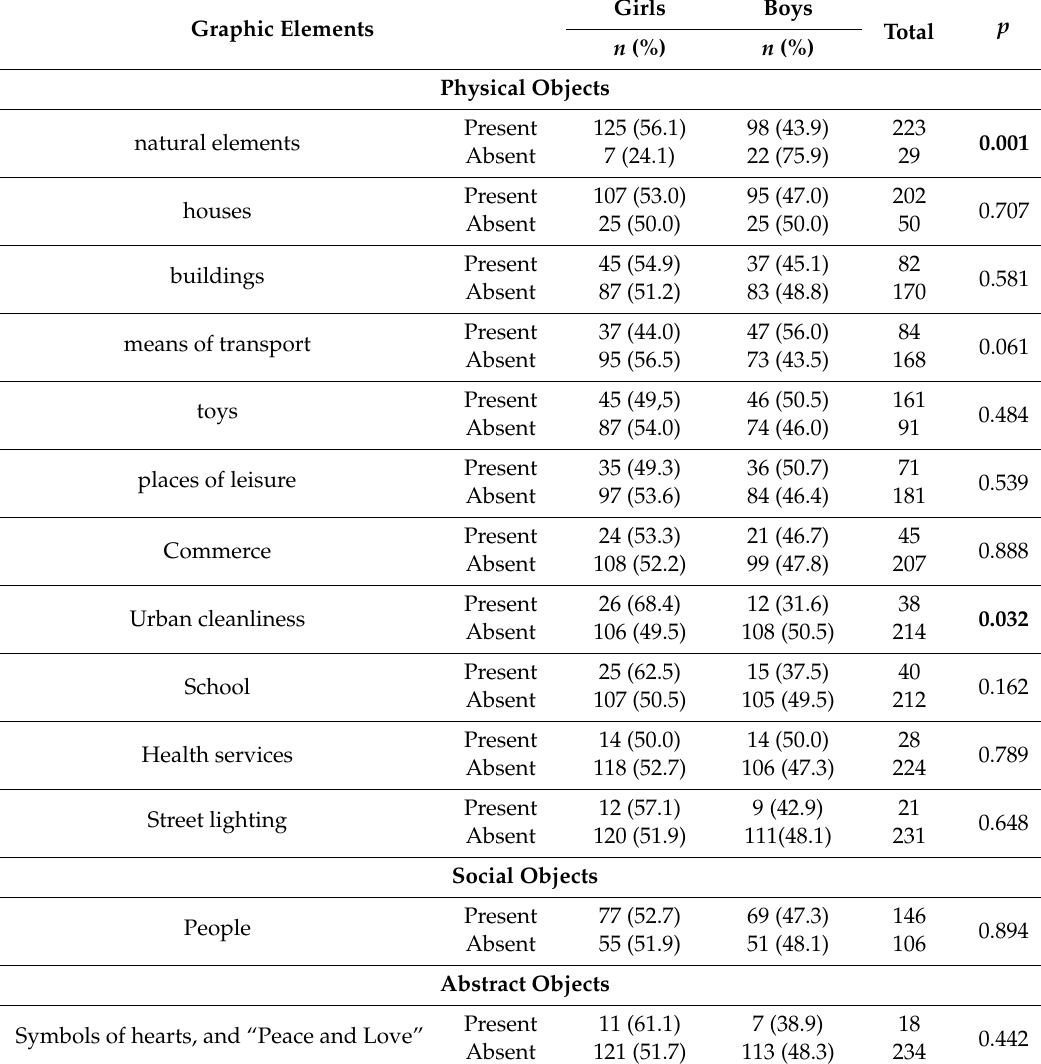
Table 1. Comparison of the graphic elements of the drawings between boys and girls, aged 6–10 years old, Brazil ( n = 252).